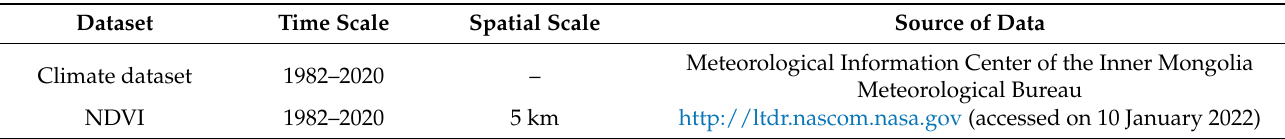
Table 1. Source of